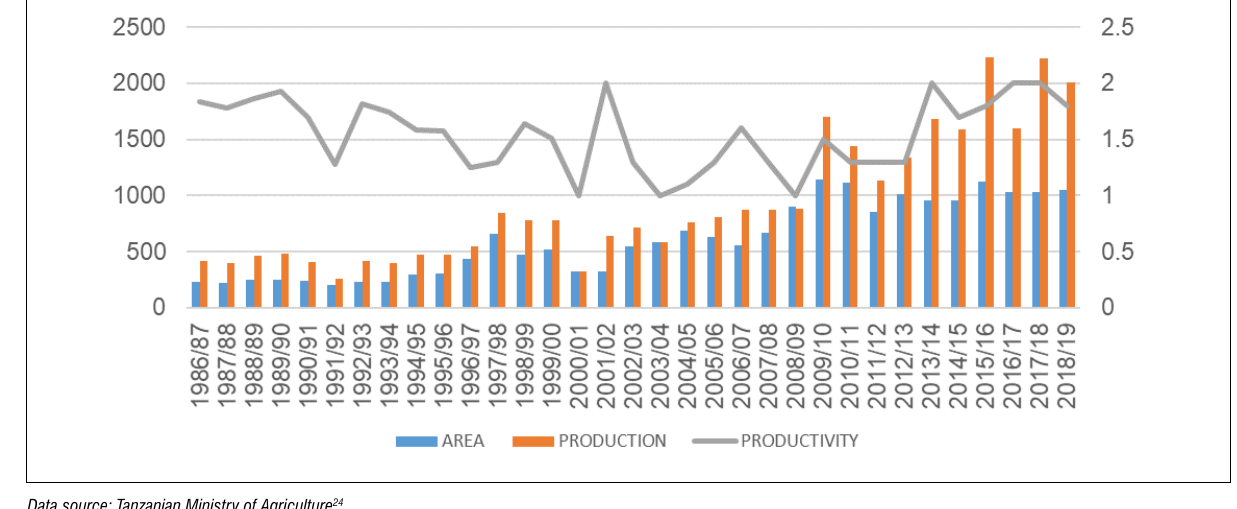
Data source: Tanzanian Ministry of Agriculture 24 Figure 1: Production of rice in Tanzania.